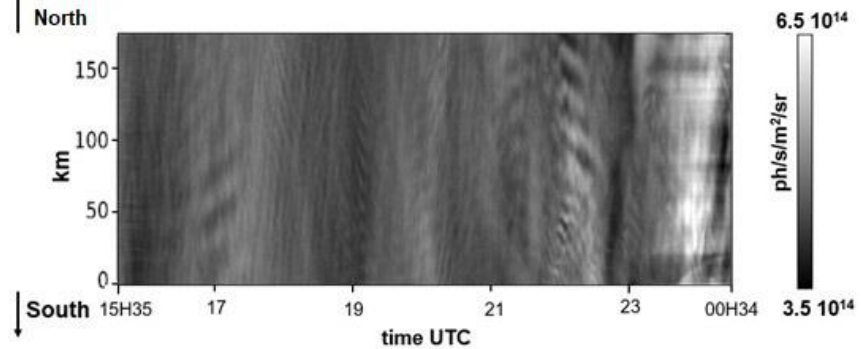
Figure 7. N/S keogram on the night of 10 October 2017.